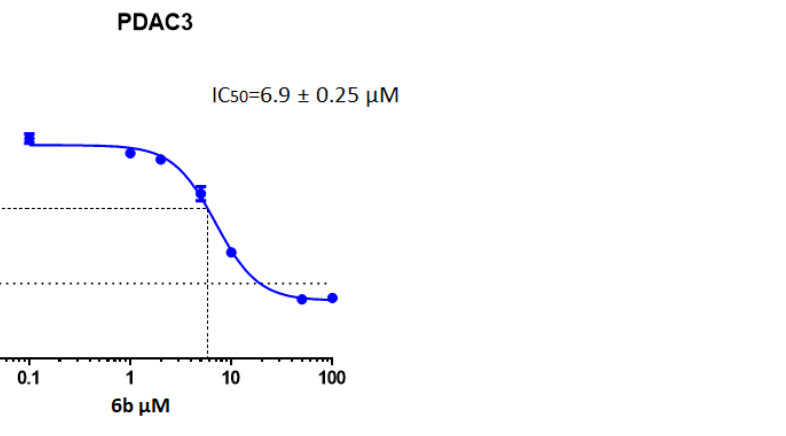
Figure 1. Representative growth inhibition curve of PDAC3 PDAC primary cells, treated for 72 h with the compound 6b . Points: mean values obtained from three independent experiments; bars: SEM.